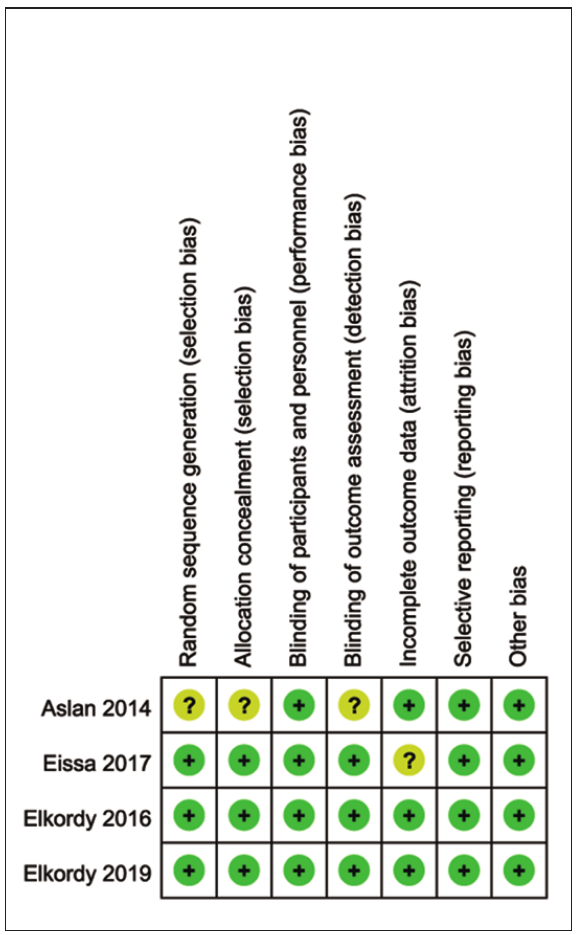
Figure 2. Risk of bias summary for